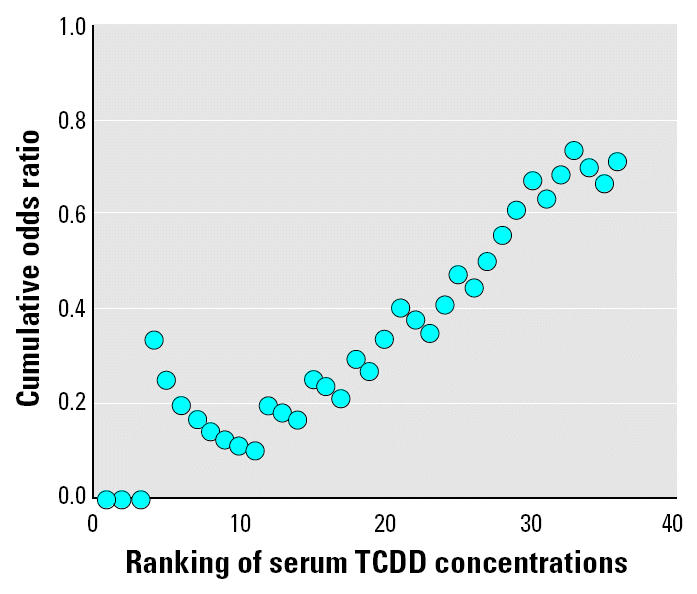
Ratio of subjects with developmental dental defects to those without at each exposure level. Subjects < 5 years of age at the time of the Seveso accident and from whom serum samples were collected soon after the accident were included (n = 36). Range of the TCDD concentrations was 31–26,000 ng/kg in serum lipid.